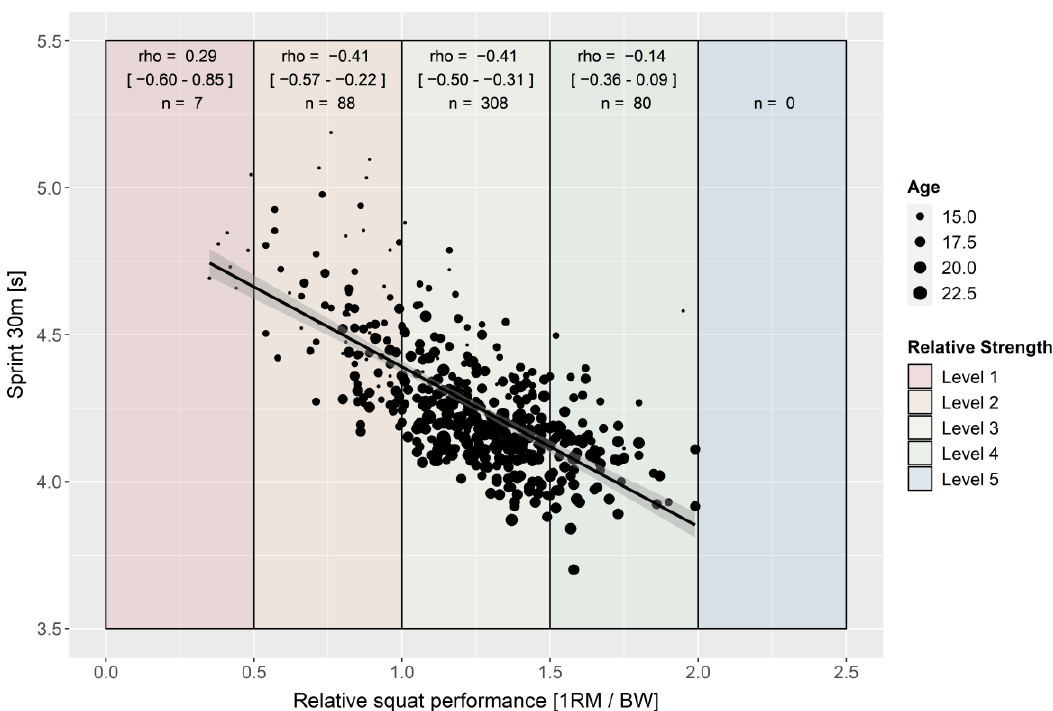
Figure 3. Scatterplot for relative squat and linear sprint performance with trendline and 95% confi- dence interval (rh o = −0 .67 [ p < 0.001; 95% C I = −0 .62 –−0 .72]; r partial = −0 .60 [CI95%= −0 .54 –−0 .6]; n = 470).